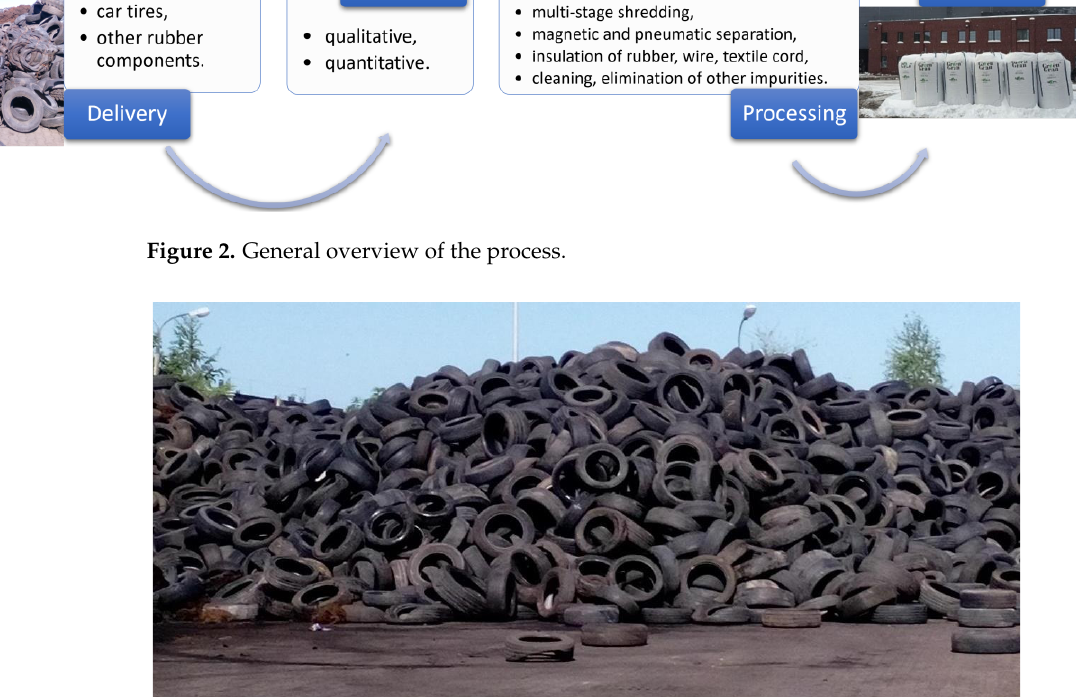
Figure 2. General overview of the process.